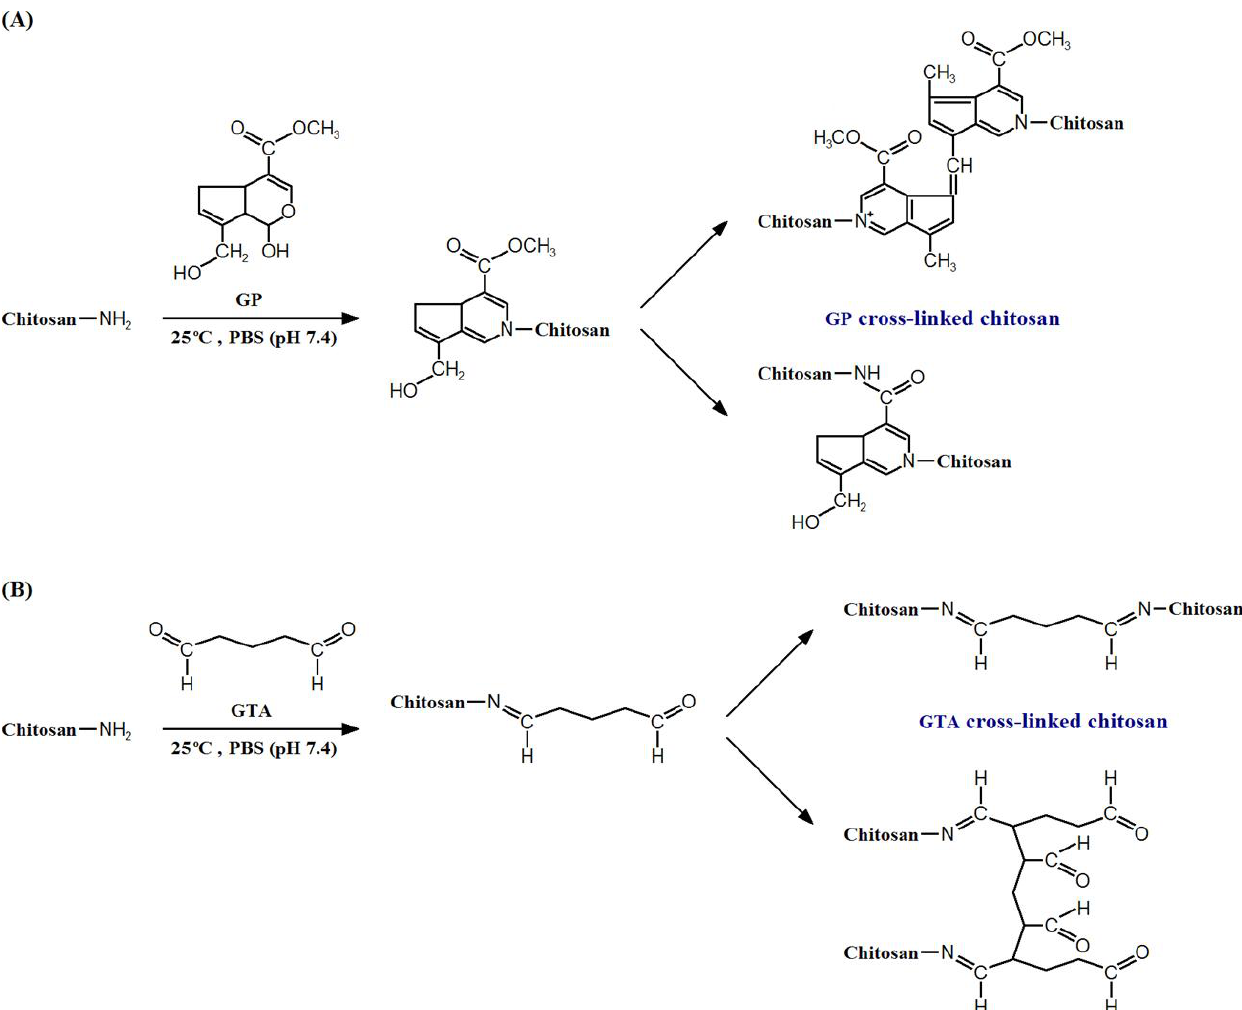
Figure 1. Cross-linking reaction scheme of chitosan with ( A ) genipin (GP), and ( B ) glutaraldehyde